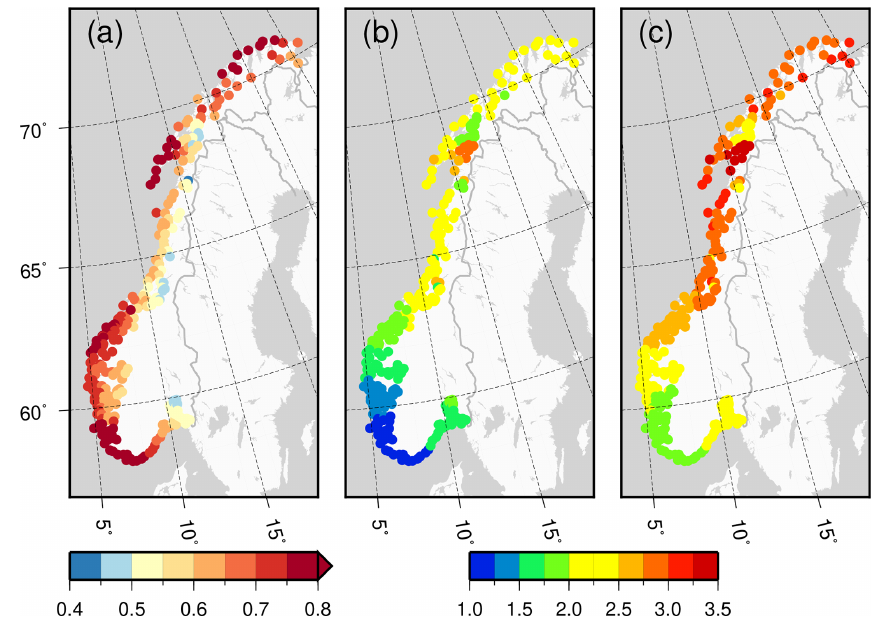
Figure 1. Projected relative sea level (RSL) change for the period 2081–2100 relative to 1986–2005 (a) , 200-year storm surge return height above MHW (b) , and the sum of these two (c) . For all figures the values are given in